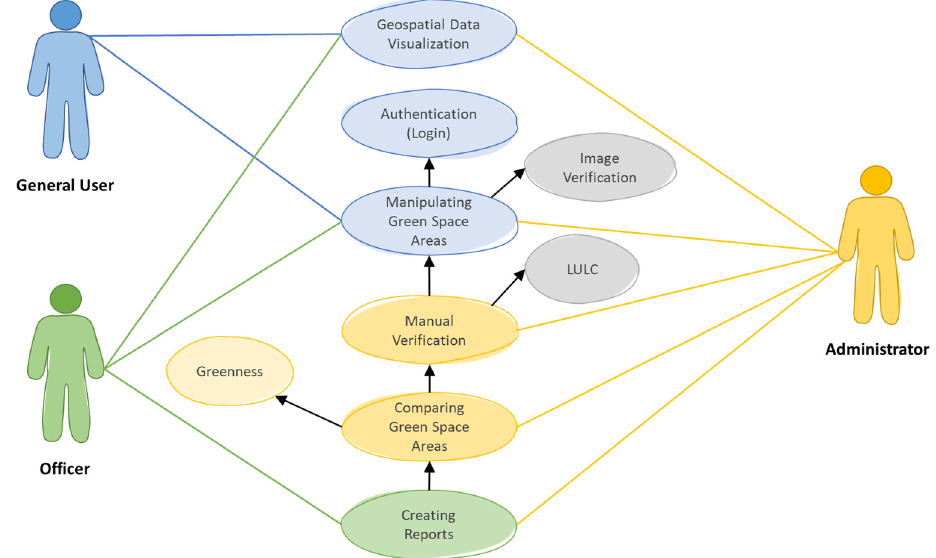
Figure 3. Use case diagram of proposed platform.